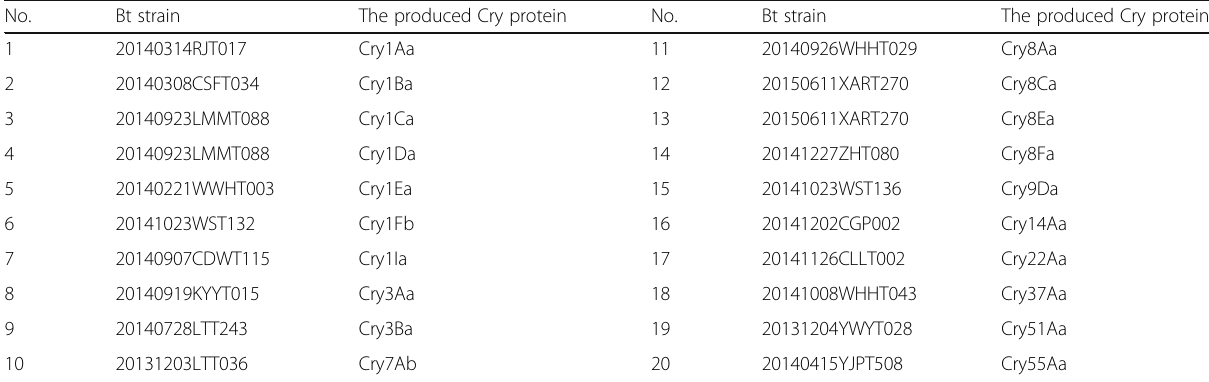
Table 1 Different Bacillus thuringiensis strains and their cry proteins No. Bt strain The produced Cry protein No. Bt strain The produced Cry